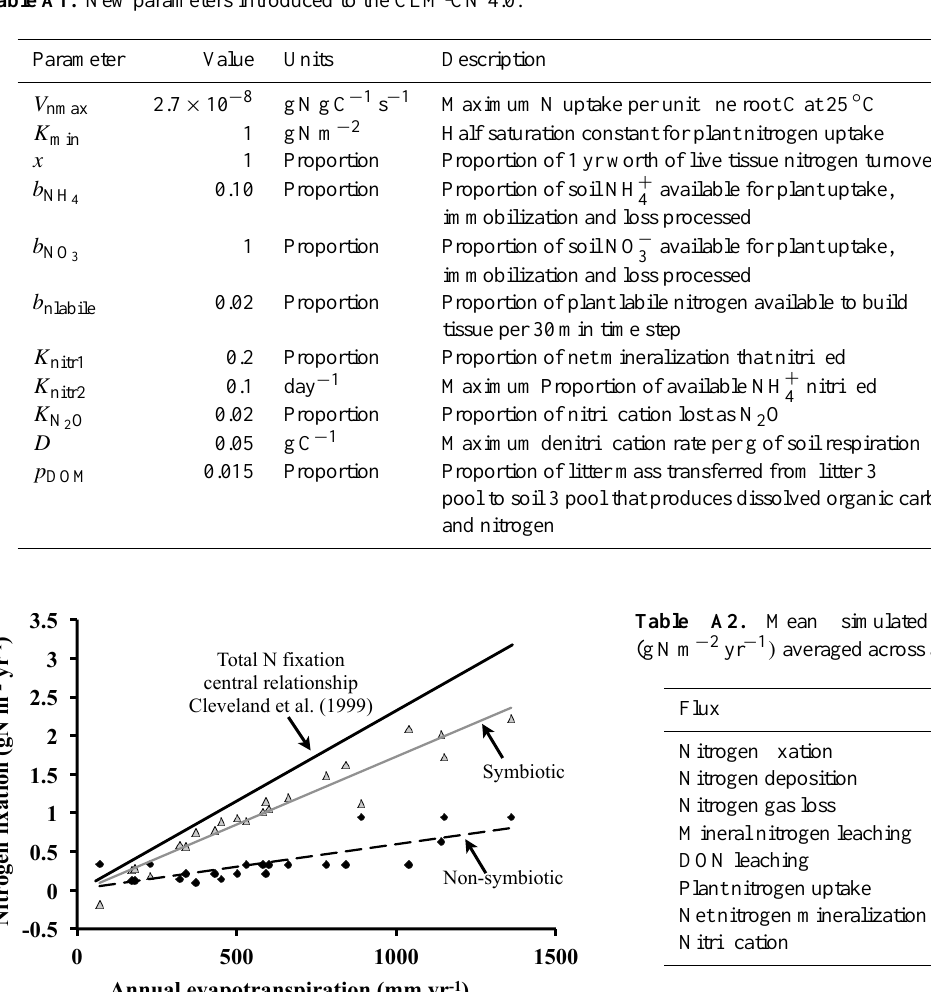
Fig. A1. The relationship between total, symbiotic and non- symbiotic nitrogen fixation and annual evapotranspiration. Data are from Cleveland et al. (1999). The relationship for total fixation is from the central N fixation line in Fig. 1 of Cleveland et al. (1999).